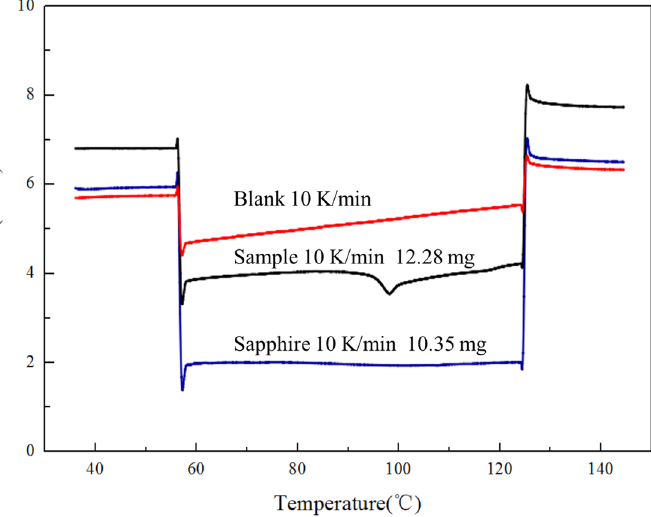
Figure 1. A typical example diagram of DSC Curves of the blank crucible, sample, and sapphire. Table 1. Chemical composition of synthesized BF